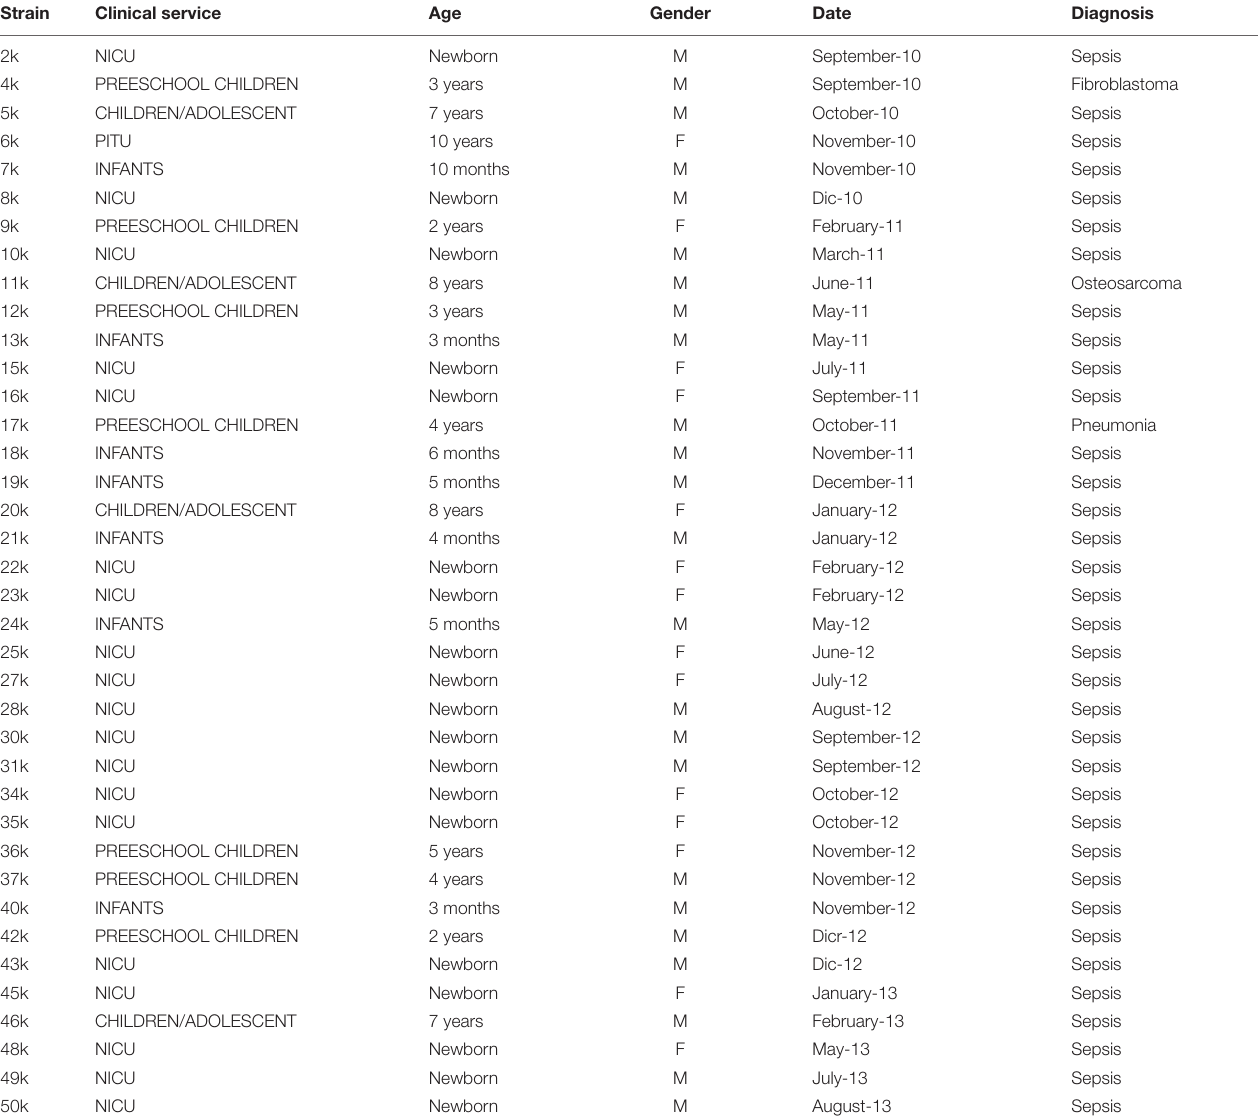
TABLE 1 | Clinical data of K. pneumoniae